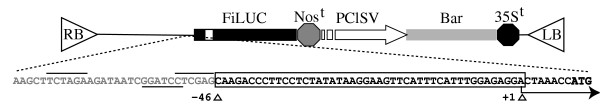
T-DNA map of plasmid 35S min (in pPZP212). T-DNA borders: RB = right border, LB = left border, FiLUC = firefly luciferase, Nost = nopaline synthase transcription terminator, PClSV = Peanut chlorotic streak virus promoter, Bar = phosphinothricin acetyl transferase, 35St = transcription terminator for the Cauliflower mosaic virus (CaMV) 35S transcript. DNA sequence insert shows the minimal 35S promoter from CaMV, from -46 to +1 (transcription start). Upstream from the minimal 35S promoter are the restriction sites (underlined: HindIII; BamH, overlined: XbaI; KpnI) used to insert test sequences and downstream is the start codon from the luciferase coding region (bold ATG).